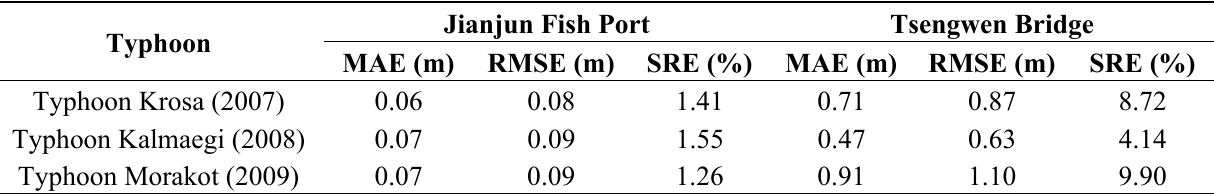
Table 1. Model performance for predicting water levels during three typhoon events at different